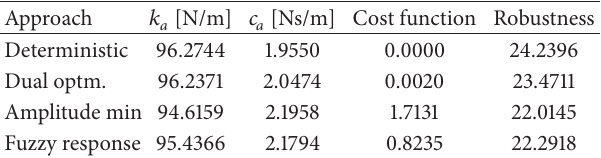
Table 3: Optimization results obtained by the DVA design problem.